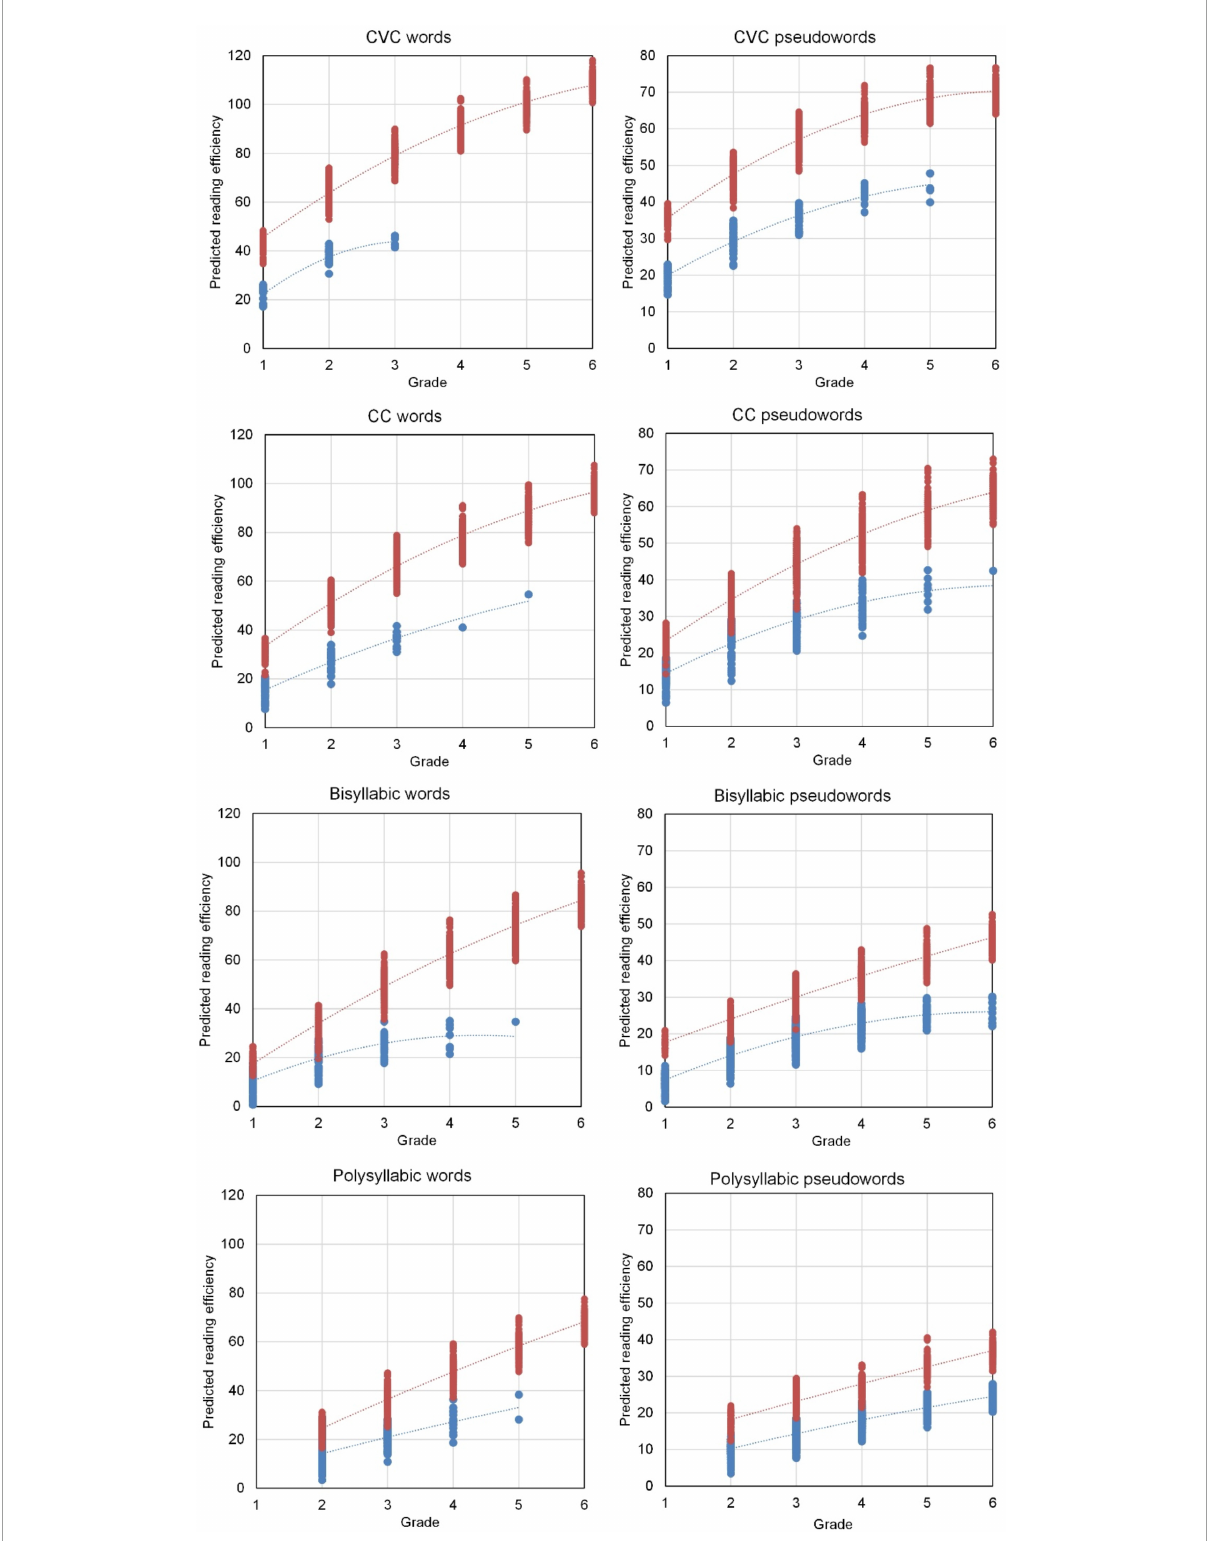
FIGURE3 Predicted reading efficiency (words per minute) per grade level for students with 80% or higher reading accuracy (in red above) and for students with less than 80% accuracy (in blue below).